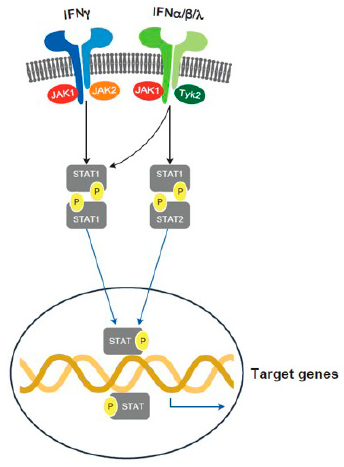
Figure 2. JAK1-TYK2 heterodimer signaling pathway.